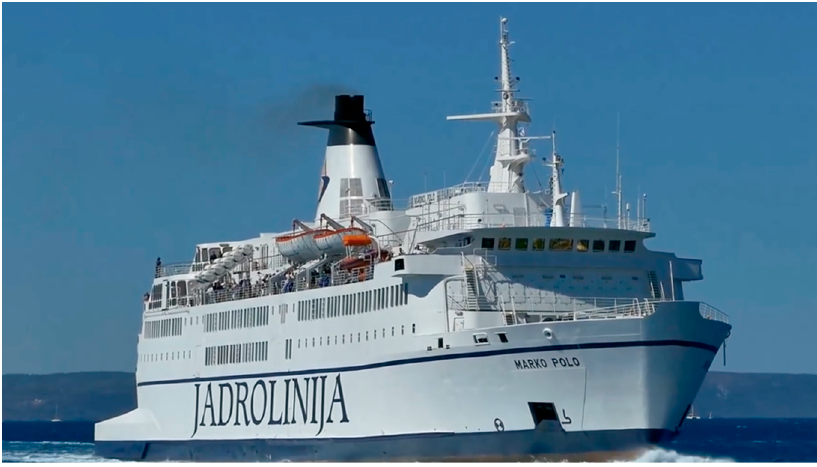
Figure 1. The RoPax ship engaged in international trade.